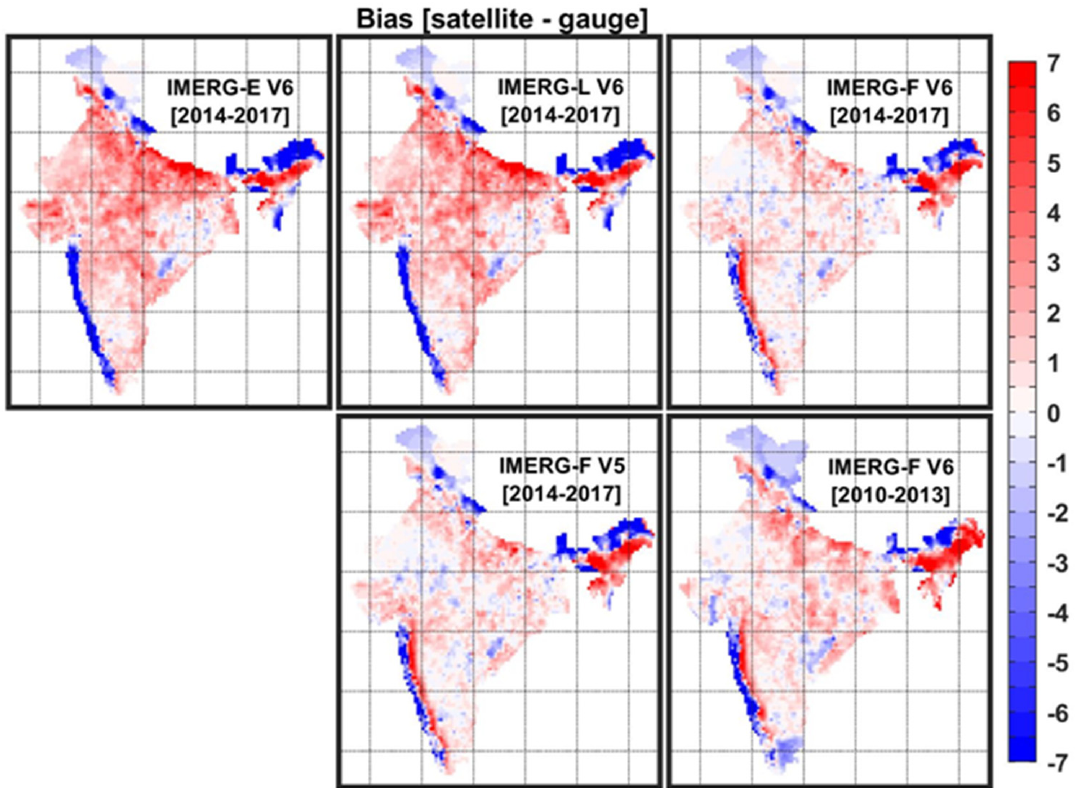
Figure 3. Spatial distributions of bias (mm day − 1 ) in the IMERG estimates as compared to the rain-gauge-based dataset over India for the GPM (2014–2017) and pre-GPM (2010–2013) periods. The spatial distributions of CV from the rain-gauge-based dataset and IMERG prod- ucts across India for the southwest monsoon season are illustrated in Figure 5. As expected, a larger magnitude of CV over the lower mean monsoon rainfall regions and smaller CV over the higher mean rainfall regions are depicted by both rain-gauge-based and multi- satellite products qualitatively. However, three Runs of IMERG V6 generally show a smaller magnitude of CV by 50–90% as compared to the rain-gauge-based product. IMERG-F V5 appears to be marginally better than IMERG-F V6 in terms of CV. Moreover, CV